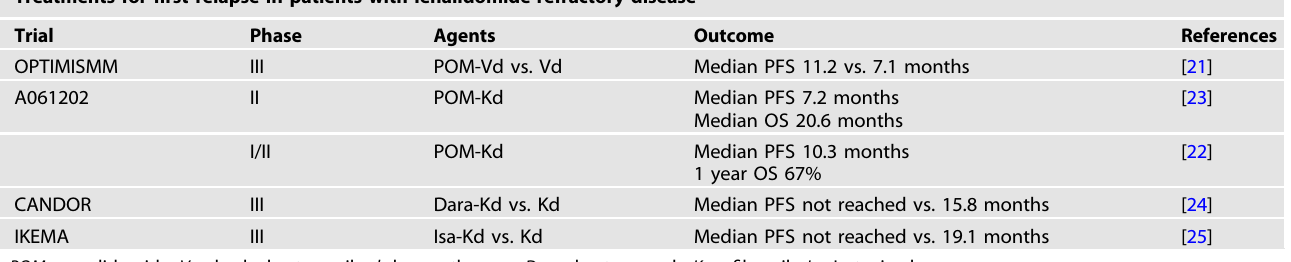
Table 1. Results of randomized clinical trials in Lenalidomide-refractory